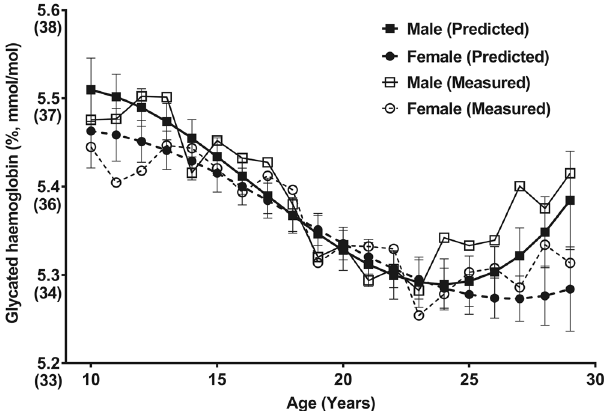
Figure 3. Predicted glycated haemoglobin with 95% confidence intervals by age and sex based on a polynomial model (adjusted R 2 = 0.056, P < 0.001).